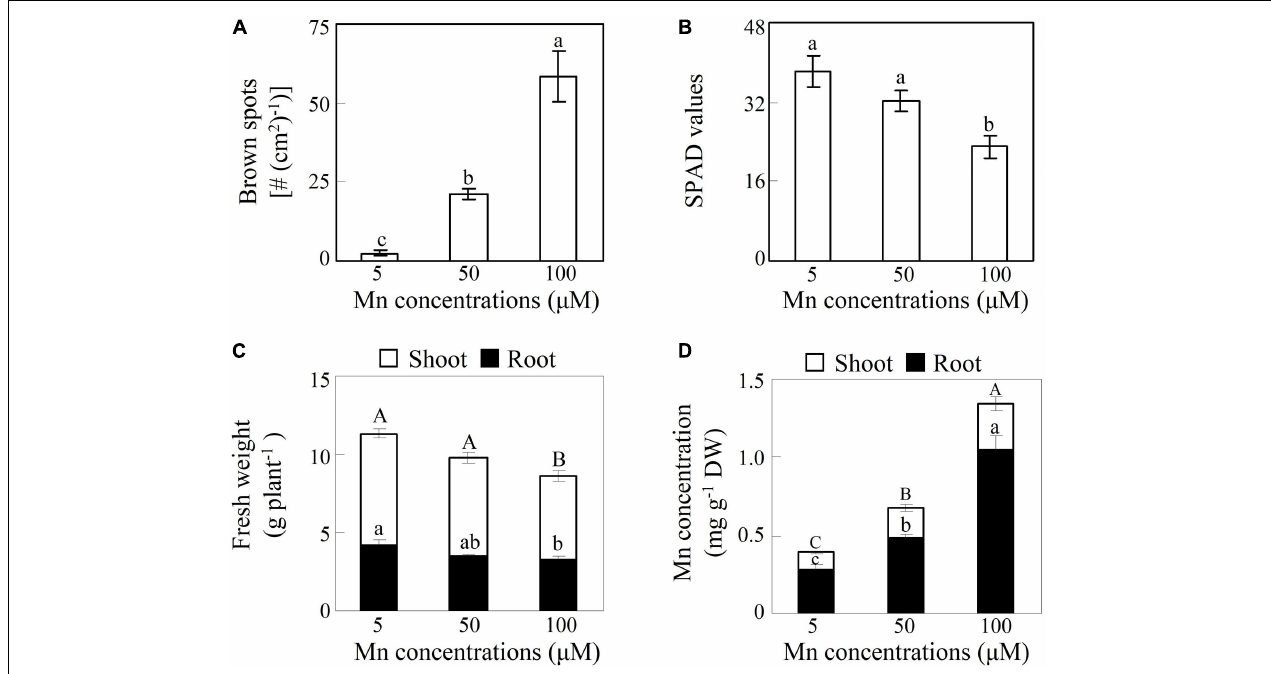
FIGURE 1 | Effects of excess manganese (Mn) treatment on soybean growth. (A) Number of brown spots. (B) Soil plant analysis development (SPAD) values. (C) Fresh weight. (D) Mn concentrations. Fourteen-day-old soybean seedlings were treated with 5, 50, and 100 µ M MnSO 4 for 7 days. Five µ M MnSO 4 was used as the control. Chlorophyll levels were detected with SPAD-502 meter. Each bar represents the means of four independent replicates with standard error. Different lower case letters indicate significant differences at P < 0.05 among Mn treatments in panels (A,B) . Different upper case or lower case letters indicate significant differences at P < 0.05 among Mn treatments in shoot or root in panels (C,D) . White and black bars represent shoot and root, respectively.